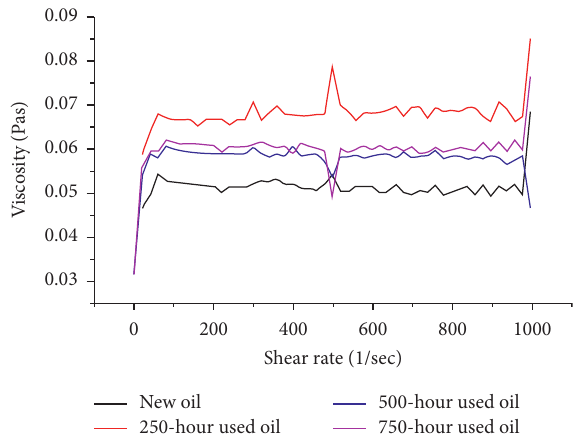
Figure 15: A combined graph of change in viscosity with shear rate at 40 ° C.